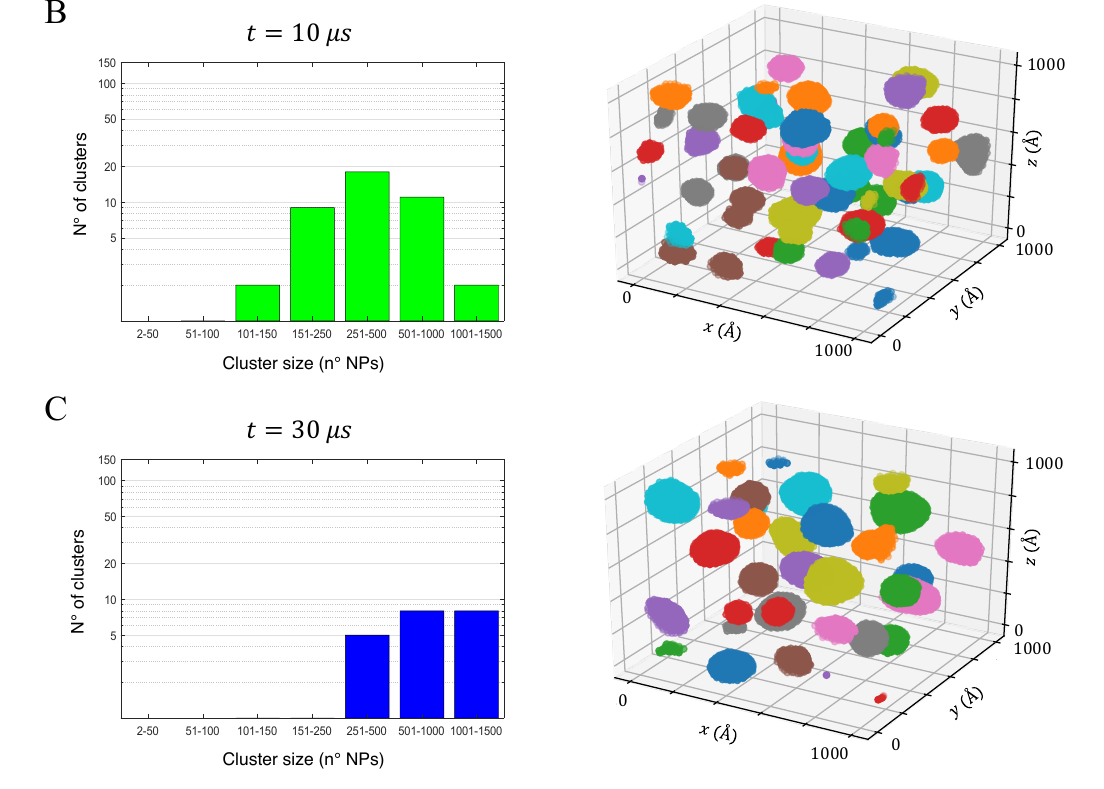
Figure 5. Aggregation kinetic of Ti O with φ = 3.5% at ( A ) 0.2 µ s, ( B ) 10 µ s and ( C ) 30 µ s. As the 111 222 simulation advances, the clusters size distribution (histograms, left-hand side) tends towards the equilibrium configuration, namely fewer and larger clusters. Note that the aggregates were colored for simplicity of representation